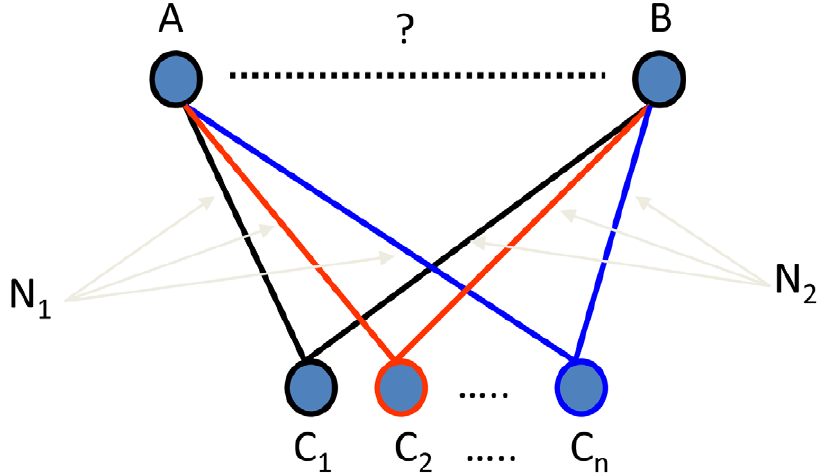
Figure 1. Computing overlay features. One feature is overlaid with another feature to generate an overlay feature. Each feature is treated as an undirected network with the genes as the nodes, and the value of the feature for a gene pair becomes the weight of the edge connecting them. Given two weighted networks N 1 and N 2 , corresponding to two features respectively, the value of the overlay feature for two nodes A and B, is the strongest (max of product of weights of the two edges) transitive link, i.e., max ( w ( A , C i ) (cid:2) w ( B , C i )) , where ( A , C i ) [ N 1 and ( C i , B ) [ N 2 or vice versa. i